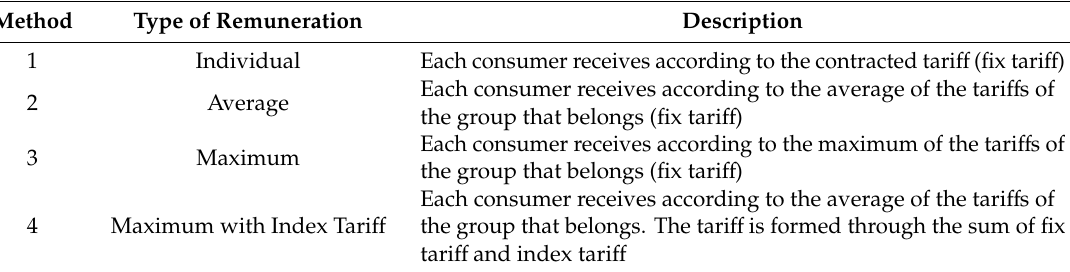
Table 4. Methods’ definition.